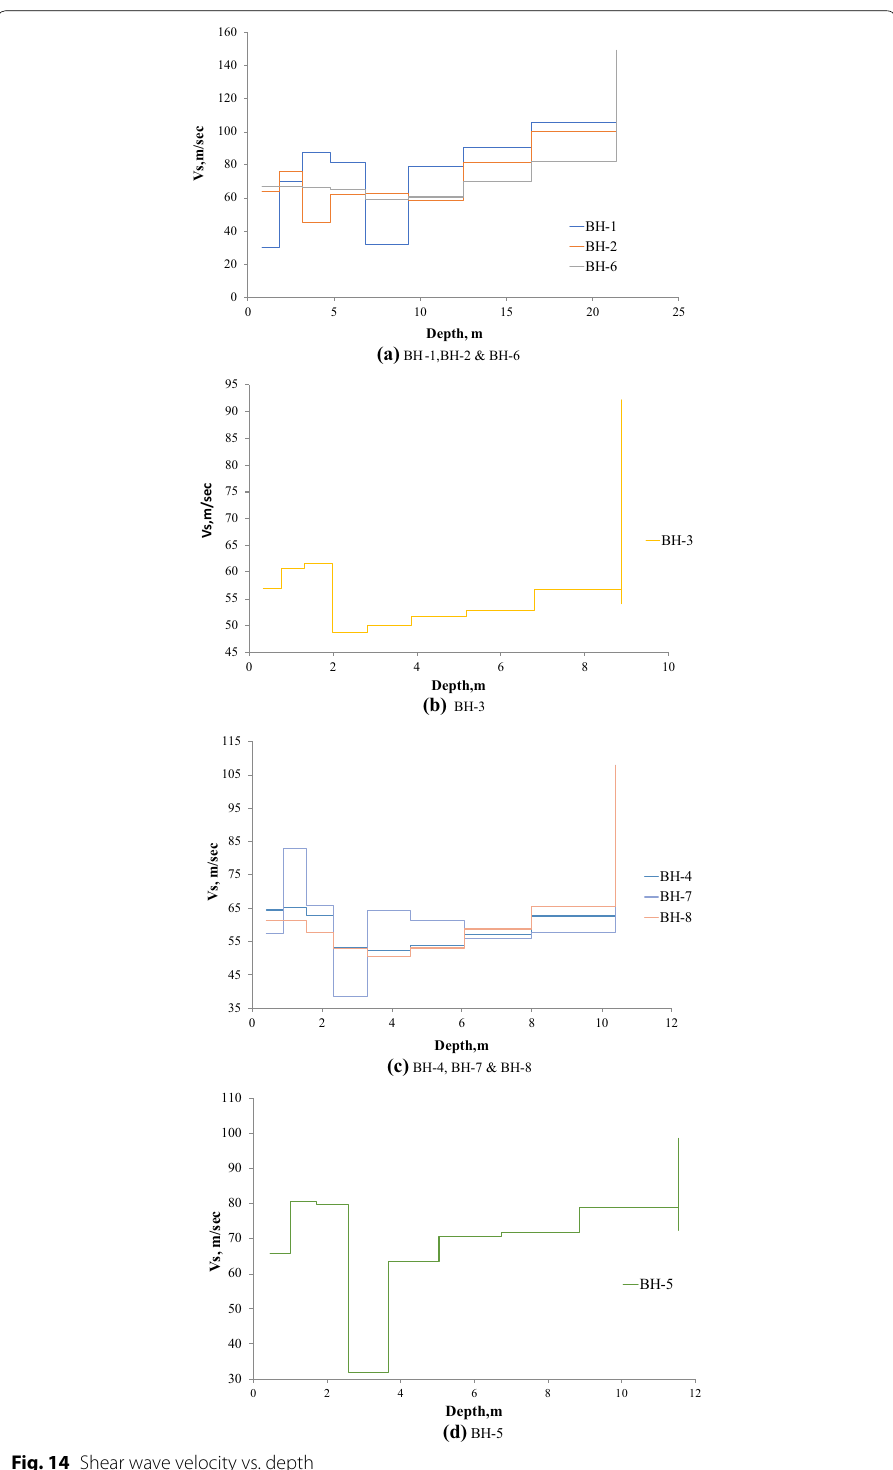
Fig. 14 Shear wave velocity vs.